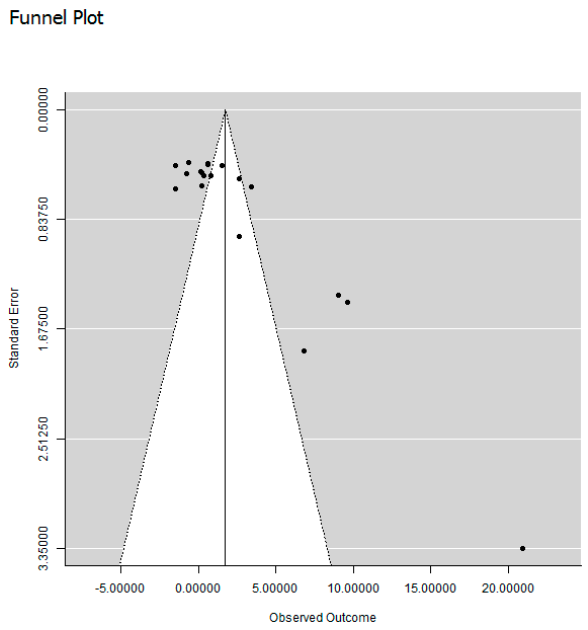
Figure 2. Funnel plot illustrating the risk for publication bias for the overall analysis of the effect of foliage inclusion on dry matter intake. Observed outcome is measured as Hedges’ d.